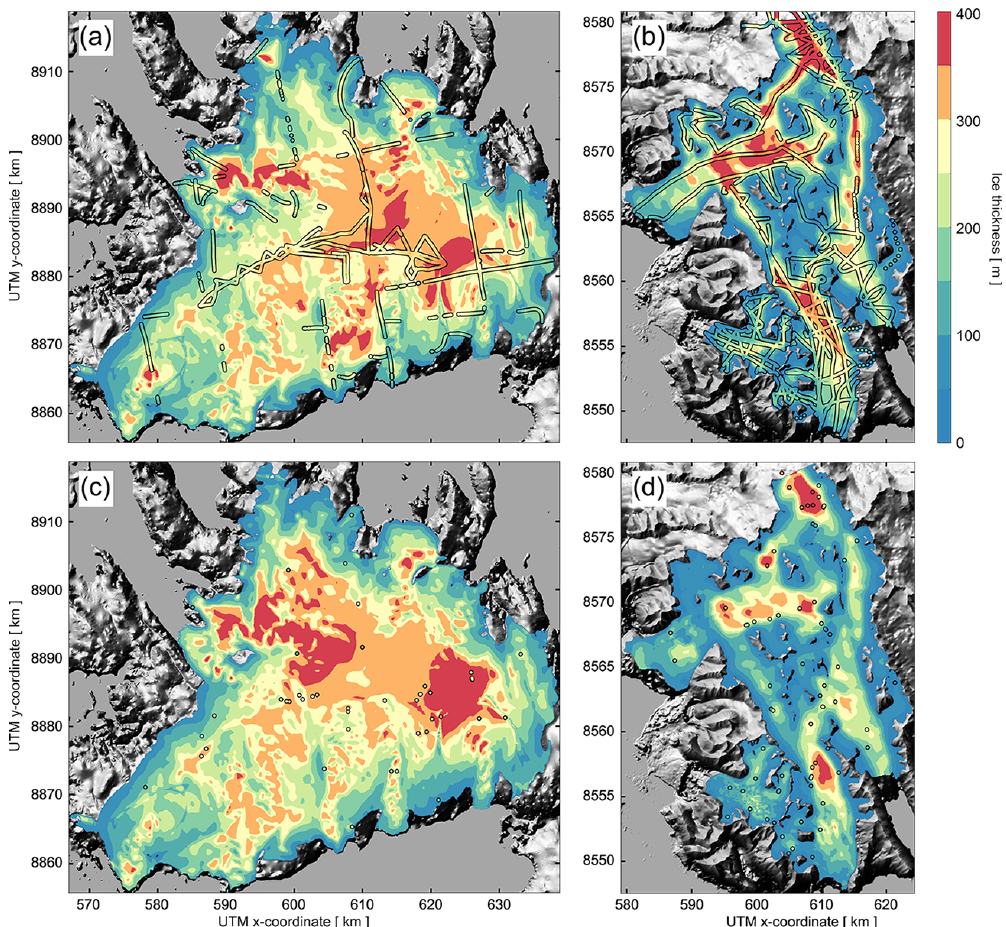
Figure C3. Ice thickness for VIC (a, c) , THPB and WSB (b, d) as in Fig. 4. Here, the first-step SIA thickness field is not corrected for negative flux values (Sect. 2.2.4). For WSB, many spots appear in central areas where ice thickness is very small. These bogus variations are a consequence of zero transitions in the flux field. For VIC and THPB such bogus variations are limited to some few small areas.